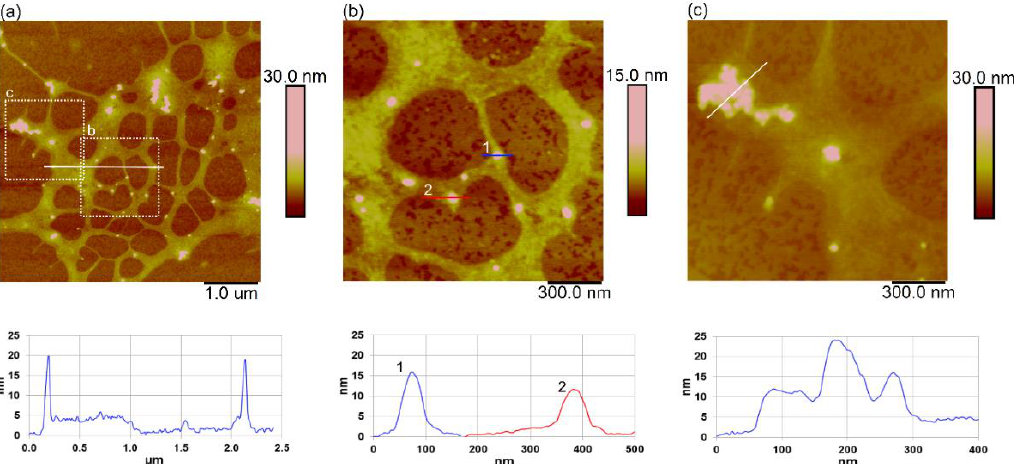
Figure 3. AFM images of suspensions of extracellular polymers (EPS, 200 µ g mL − 1 ) spiked with SiO 2 (10 µ g mL − 1 ) prepared in filtered natural seawater. AFM images were acquired using tapping mode in air and presented as height data, with scan sizes 5 µ m × 5 µ m ( a ); and 1.5 µ m × 1.5 µ m ( b , c ). Corresponding vertical profiles along the indicated lines show particle and fibril heights. Line crossing nanoparticles and belonging vertical profile along indicated line in (b) are shown in the same color and indicated by the same number.